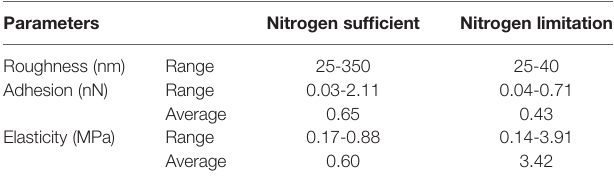
TABLE 1 | Surface characteristics of P. donghaiense measured by